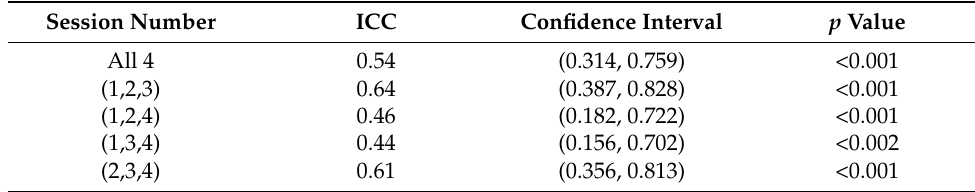
Table 5. Intra Class Correlations for Test–retest of MATADOC scores by session. Session Number ICC Confidence Interval p